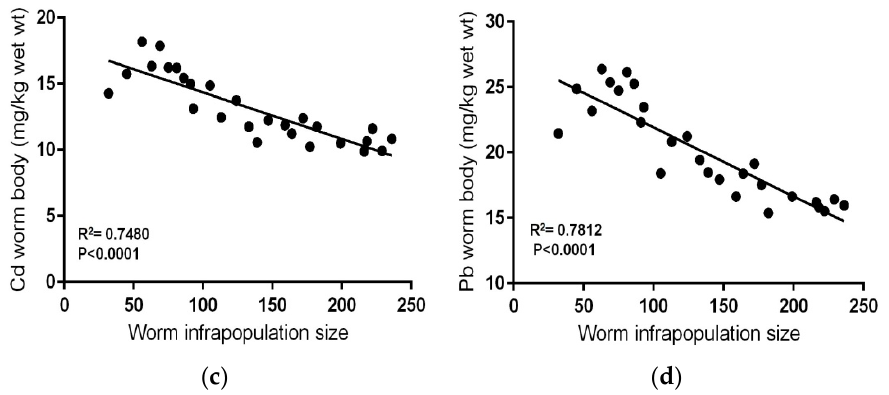
Figure 2. The relationships between metal concentrations in fish liver or in worm body and worm infrapopulation size in fish intestine: ( a ) Cd concentrations in fish liver vs. worm infrapopulation size, ( b ) Pb concentrations in fish liver vs. worm infrapopulation size, ( c ) Cd concentrations in worm body vs. its infrapopulation size, ( d ) Pb concentrations in worm body vs. infrapopulation size. The mean levels of serum liver enzymes, ALT, AST, ALP, and GGT in contaminated- infected fishes were significantly lower than those in contaminated–uninfected fishes ( p < 0.05) (Table 2), and clear negative relationships were found between levels of these enzymes and worm infrapopulation size ( R 2 = 0.744, p < 0.0001; R 2 = 0.8309, p < 0.0001; R 2 = 0.8834, p < 0.0001; R 2 = 0.8675, p < 0.0001, respectively) (Figure 3a–d). Similarly, mean levels of serum glucose and triglycerides in contaminated–infected fishes (Table 3) were significantly lower than those in contaminated–uninfected fishes ( p < 0.05), and clear negative relationships were found between these levels and worm infrapopulation size (R 2 = 0.8618, p < 0.0001; R 2 = 0.8445, p < 0.0001) (Figure 4a,b).However, mean levels of serum total protein and albumin in contaminated–infected fishes were higher than those in contaminated- uninfected fishes (Table 3), and clear positive relationships were found between these levels and worm infrapopulation size ( R 2 = 0.7609, p < 0.0001; R 2 = 0.7697, p < 0.0001) (Figure 4c,d).Moreover, mean level of serum urea in contaminated–infected fishes was significantly lower than that in contaminated–uninfected fishes ( p < 0.05) (Table 3), and a clear negative relationship was found between this level and worm infrapopulation size ( R 2 = 0.8339, p < 0.0001) (Figure 4e).